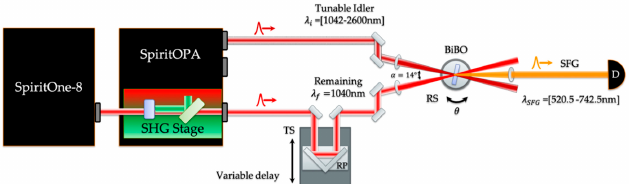
Figure 1. Schematic view of the experimental setup used for measuring the sum-frequency generation (SFG) across the 520.5 to 742.5 nm region from two femtosecond pulses superimposed within a BIBO crystal. The BIBO crystal is mounted on a rotation stage (RS) in a noncollinear phase-matching configuration with a fixed angle α = 14 ◦ . The variable delay line is used to temporally overlap the remaining pulse ( λ f = 1040 nm) behind the second harmonic generation (SHG) stage of SpiritOne-8 laser and the λ i pulse from the tunable range 1042–2600 nm of the automated collinear optical parametric amplifier (SpiritOPA) with the help of a translation stage (TS) and a retroreflector prism